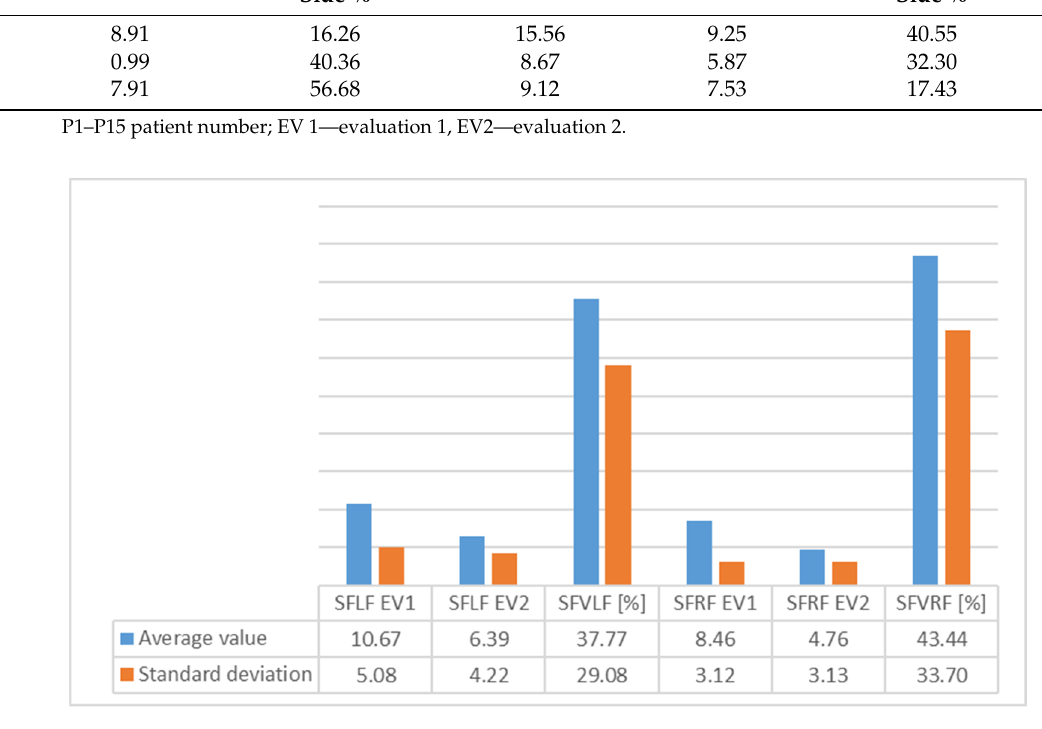
Figure 5. Variation of average values and standard deviation for subtalar flexibility for Group 2 between EV1 and EV2 (SFLF = subtalar flexibility for left foot; SFVLF = subtalar flexibility variation for left foot; SFRF = subtalar flexibility for right foot; SFVRF = subtalar flexibility variation for right foot).